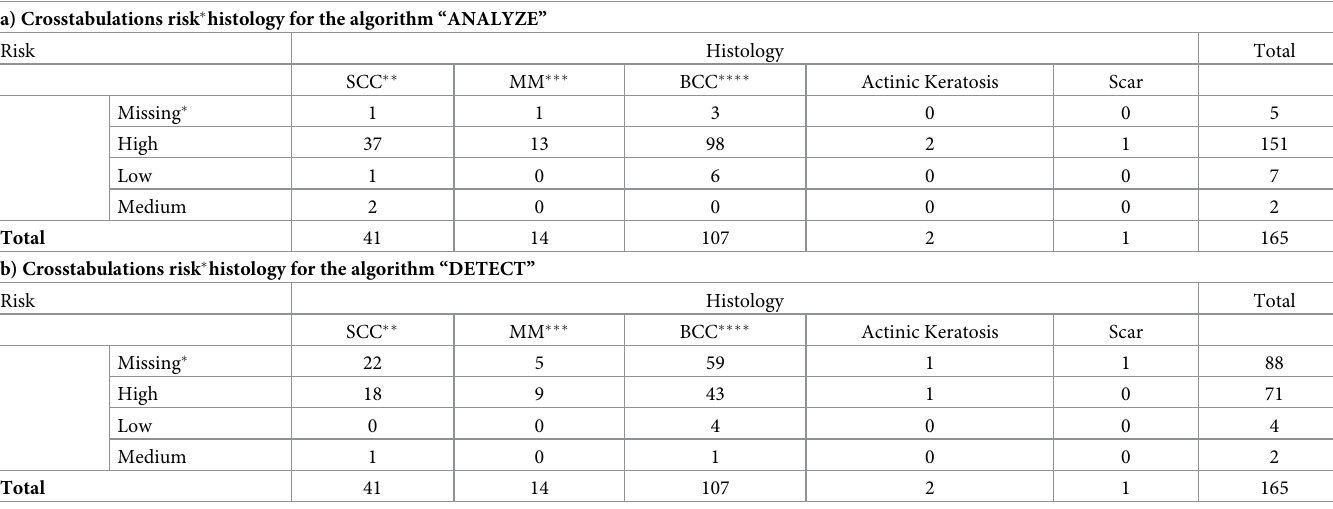
� Missing risk value: In some cases, the algorithm did not assess the risk for the respective lesion due to a software error. � Missing risk value: As the „ANALYZE” algorithm evaluation started before the “DETECT” algorithm was introduced, some lesions were only assessed by “ANALYZE” explaining missing risk values for “DETECT”.